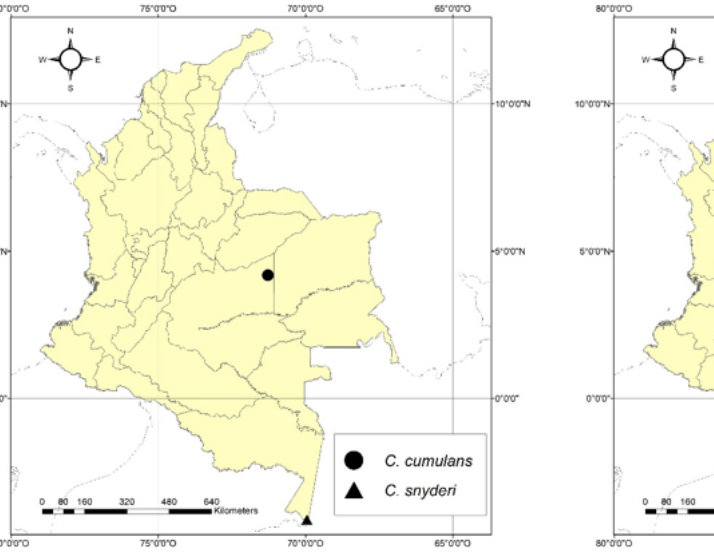
Figure 1. Distribution map of Cornitermes cumulans and Cornitermes snyderi .